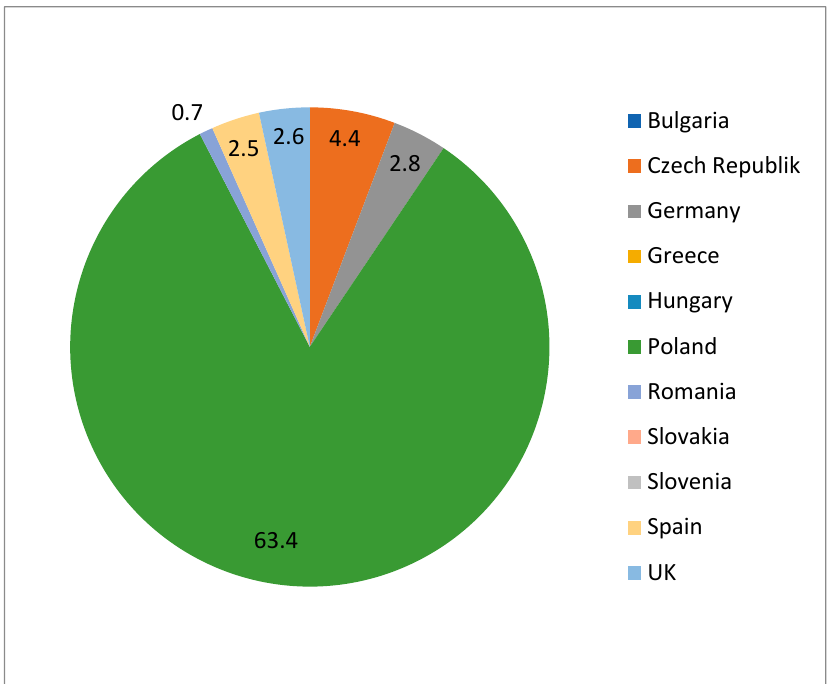
Figure 2. Hard coal production (in mln t). Source: author’s study based on Euracoal Market Reports, http://euracoal2.org (accessed on 1 February 2022).